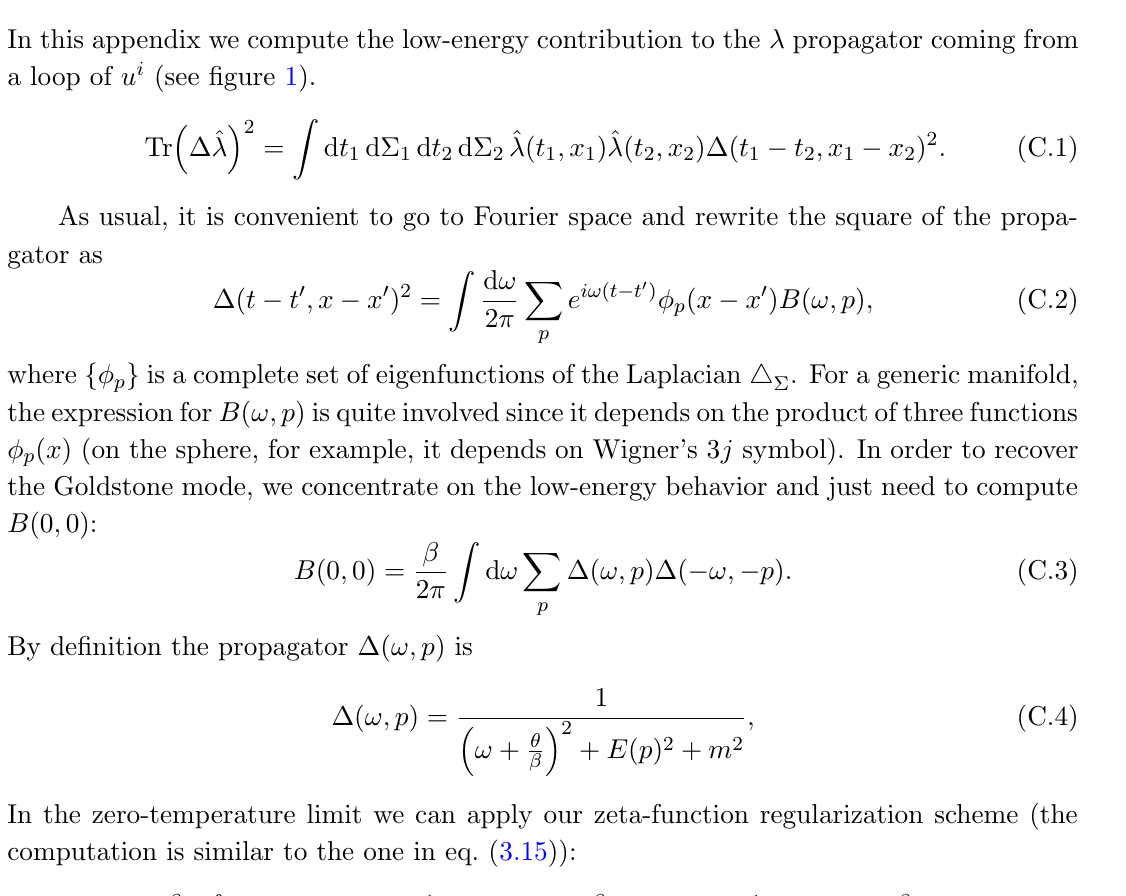
Figure 2 . Ratio of two consecutive coe(cid:14)cients in the asymptotic expansion of (cid:16) ( s In both cases the optimal truncation is at the fourth term. After that coe(cid:14)cient of the next-order term becomes larger than the previous